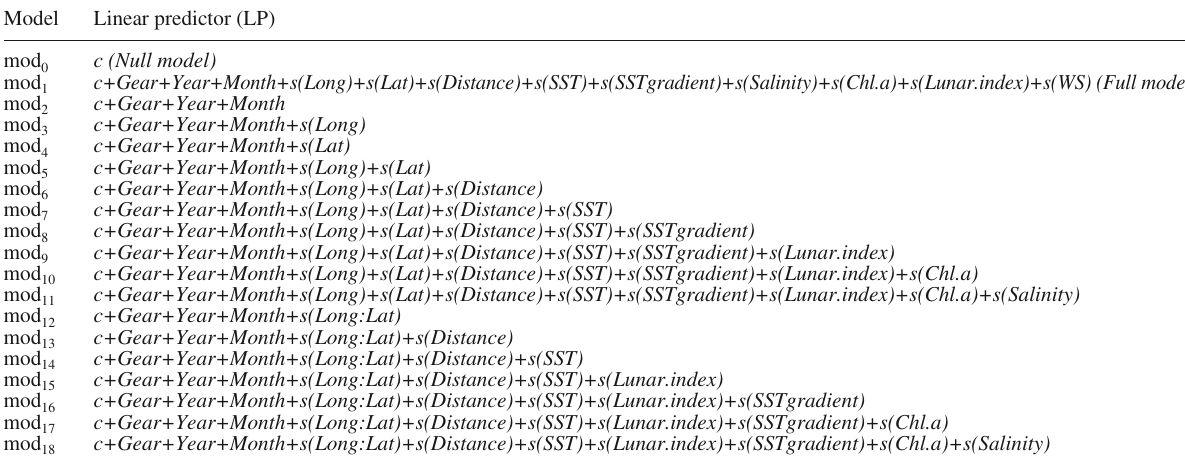
Table 3. – The set of candidate models. (“:” denotes interaction between predictors).